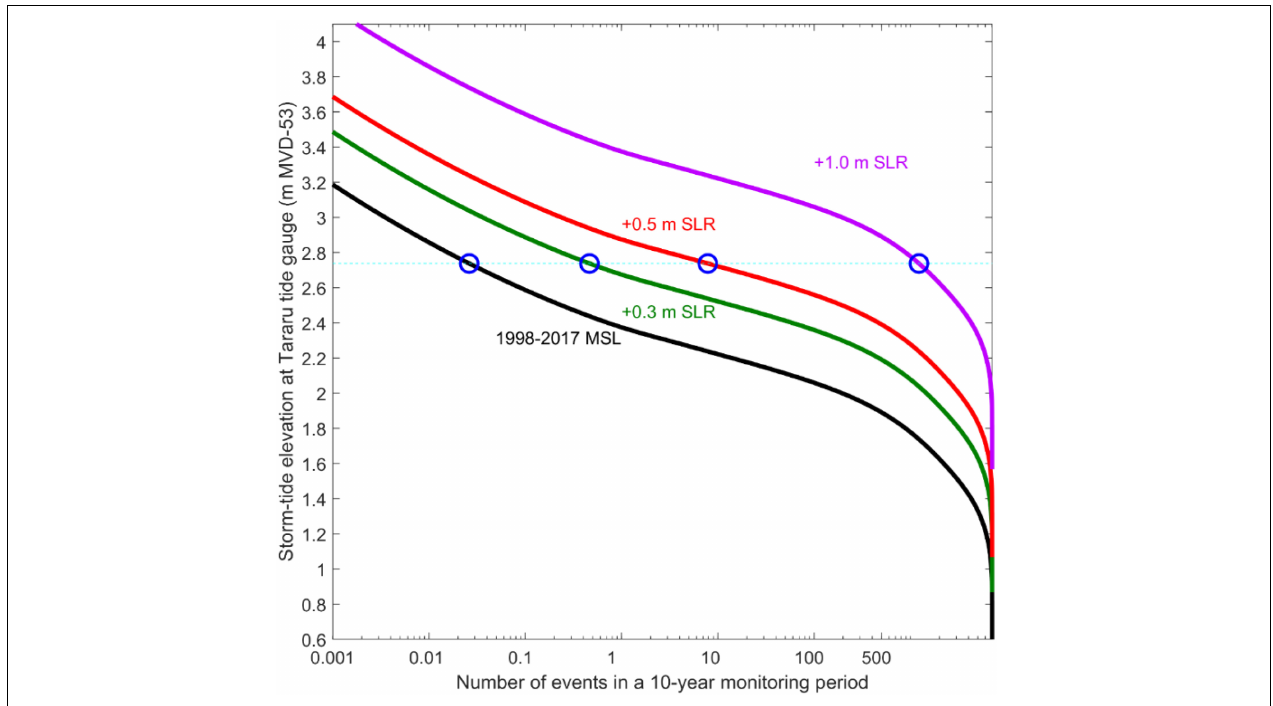
FIGURE 3 | Change in frequency of storm-tide flooding with SLR at Tararu, Thames, Coromandel, New Zealand. The nomographs are derived by transforming the high-water exceedance curve in Figure 2 following methods in Stephens et al.